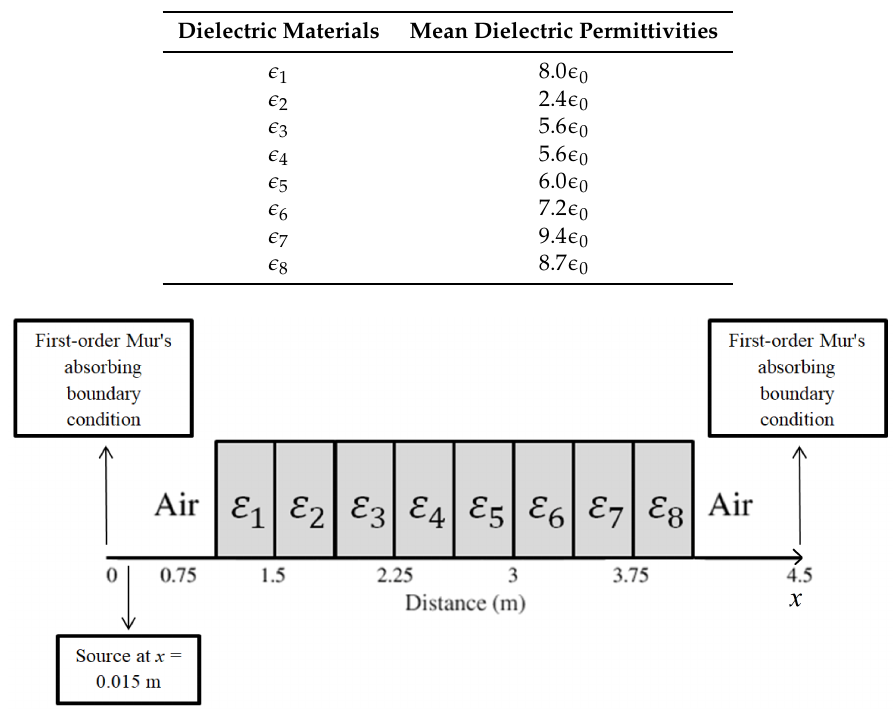
Table 1. Mean dielectric permittivities for the transmission-line problem.